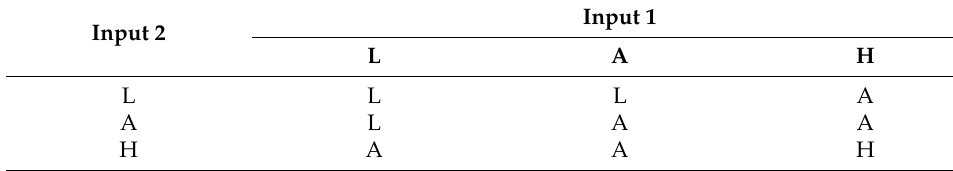
Table 3. Fuzzy IF-THEN α rules.